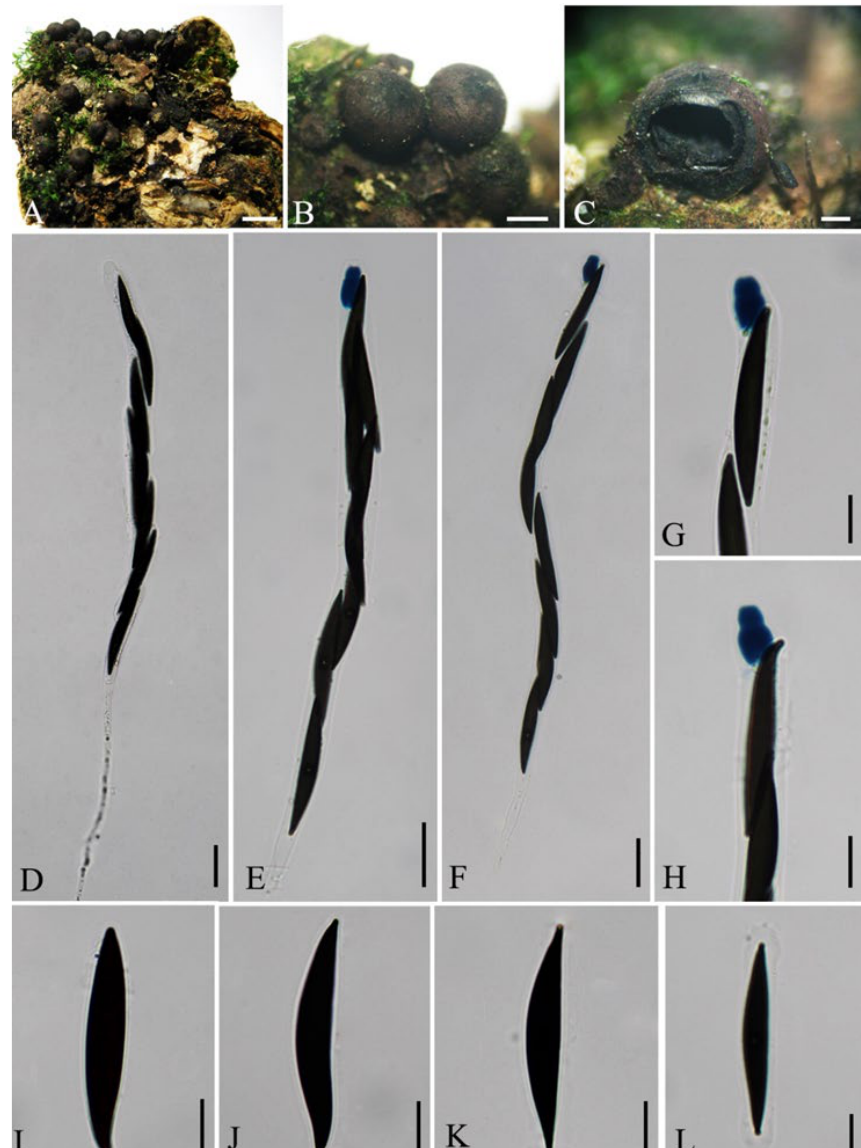
Figure 3. Dematophora necatrix (GZUH0139) ( A , B ) Stromata on the host; ( C ) Vertical section of a stroma; ( D – F ) Asci; ( G , H ) Urn–shaped J+ apical rings (stained in Melzer’s reagent); ( I – L ) Ascospores. Bars: ( A ) = 2 mm, ( B ) = 500 µ m, ( C ) = 200 µ m, ( D ) = 20 µ m, ( E – H ) = 20 µ m, ( I – L ) = 10 µ m. Descrption—see Petrini